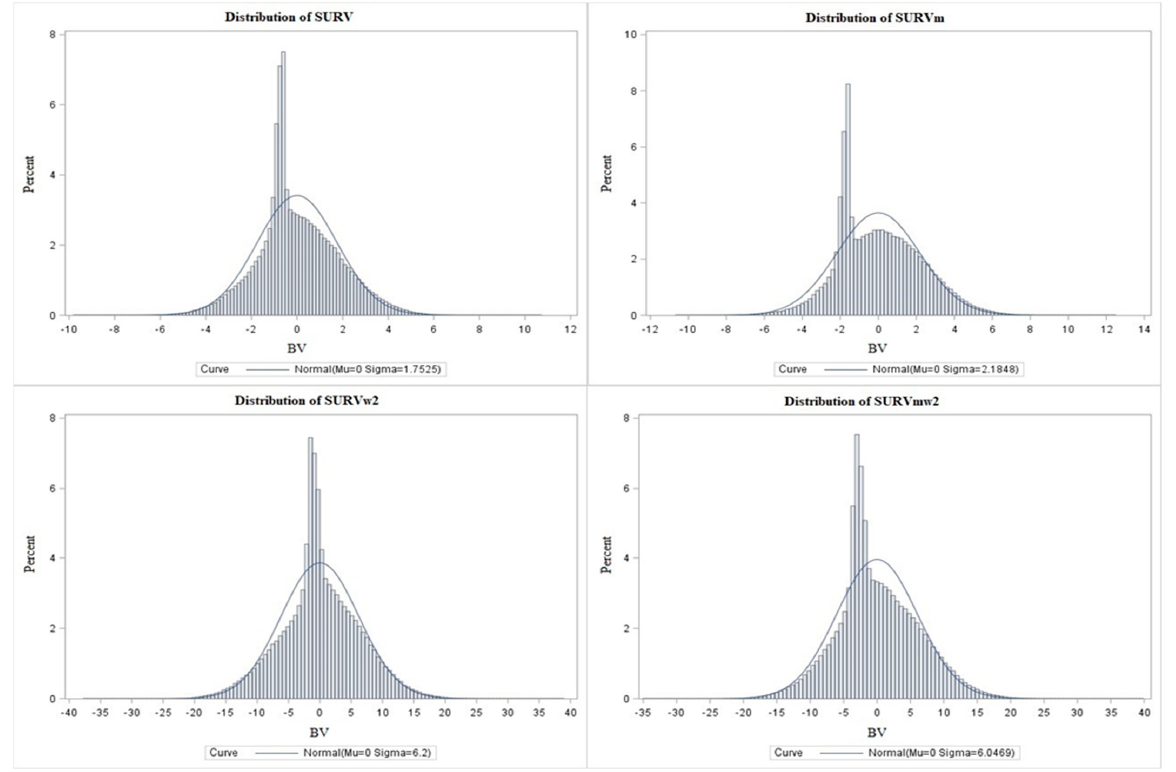
Figure 2. Breeding values frequency distributions: calculations without SURV and SURVm weights and according to level (w2) SURVw2 and SURVmw2 weight.